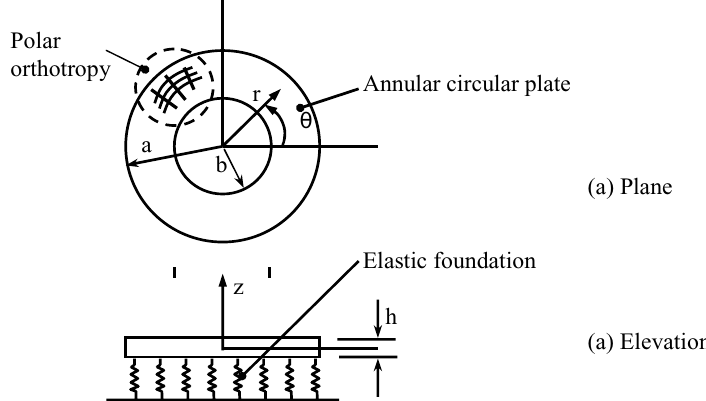
Fig. 1. Annular circular plate resting on elastic